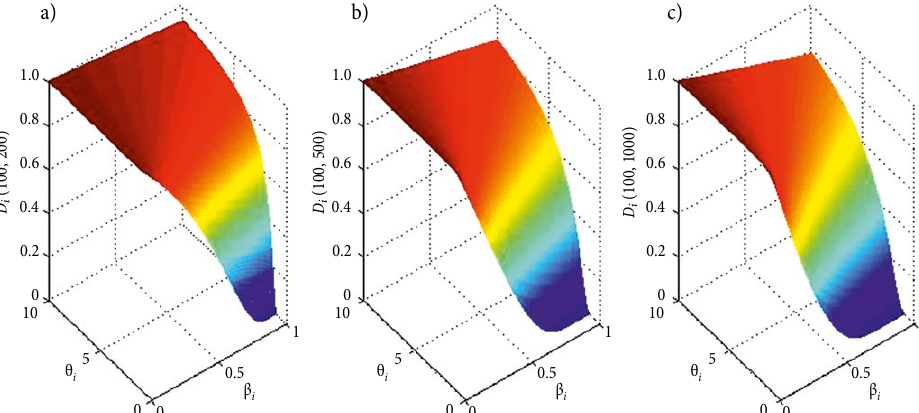
Fig. 2. The survival probability D (a) j = 100, t = 200; (b) j = 100, t = 500; (c) j = 100, t =